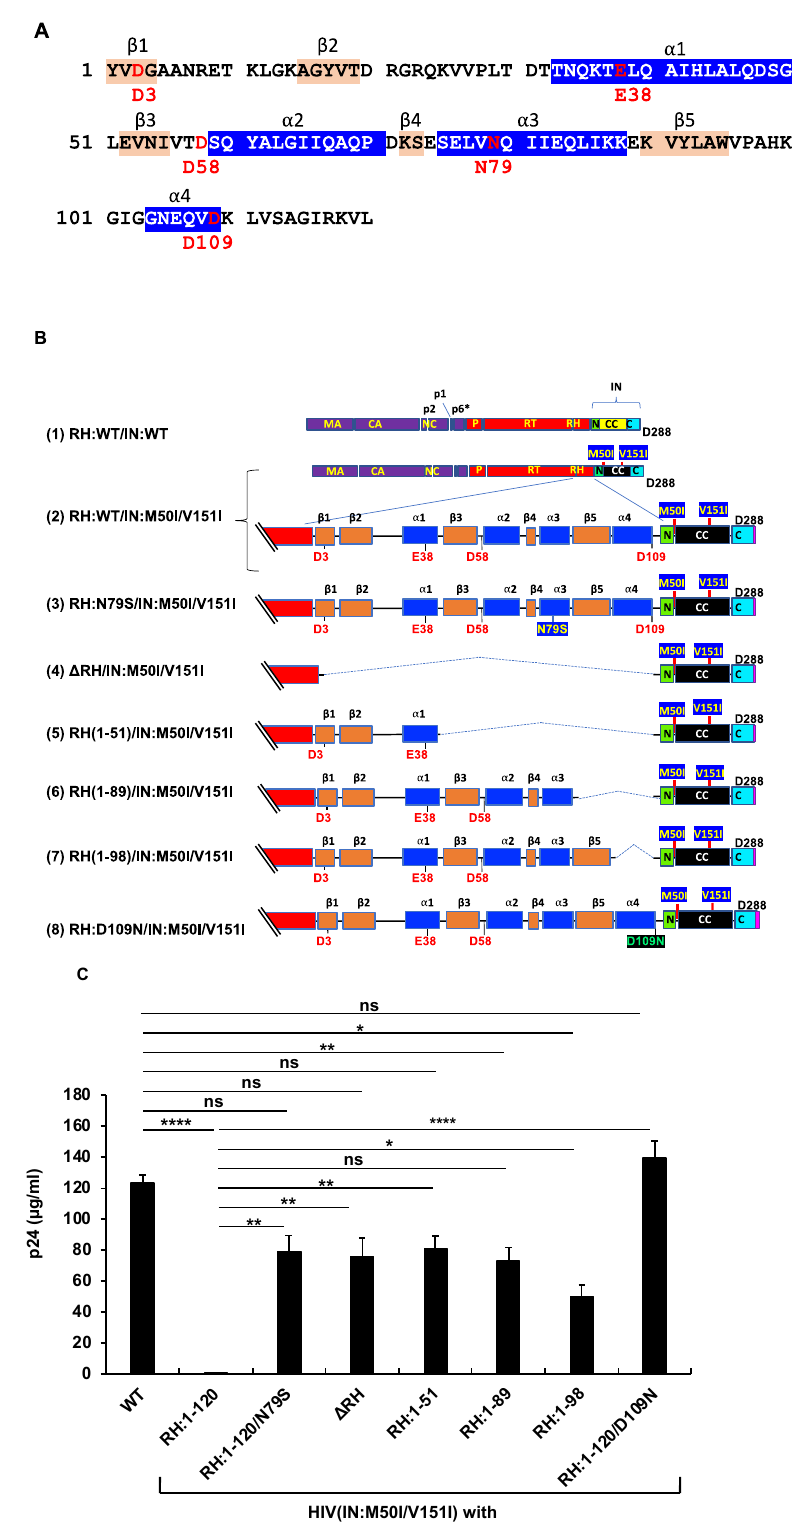
Figure 1. The C-terminal domain of RH regulates virus release and autoprocessing. ( A ) Amino acid sequence of RH. Amino acid sequence of RH of HIV NL4.3 [33] was obtained from GenBank (accession #: AF324493). The alpha helices are colored in blue, and the beta strands are colored in wheat; codons associated with the active sites (D3, E38, D58, and D109) and mutation position 79 (N79) are labeled and colored in red with numbering. ( B ) Diagrams of HIV mutants containing mutations in RH. The diagram indicates the structure of GagPol(WT) and variants. The numbers above the diagrams in- dicate codon positions in RH. Each mutant was created by inverting PCR or site-directed mutagen- esis, as described in the Materials and Methods (Section 2.3). MA: matrix protein; CA: capsid pro- tein; NC: nucleocapsid protein; P: protease; RT: reverse transcriptase; RH: RNase H; IN: integrase; N: the N terminal domain of IN; CC: the catalytic core domain of IN; C: the C terminal domain of IN; α 1~ α 4 and β 1~ β 5 are corresponding to domains of RH in Figure 1A. ( C ) Each construct was transfected into HEK293T cells. Transfection supernatants from HEK293T cells were collected, and then viral particles were pelted as described in the Materials and Methods (Section 2.4). Each viral pellet was resuspended in 1/100 of the transfection supernatants in complete culture media or PBS. p24 concentrations in the suspension were determined by measuring HIV p24 antigen by ELISA. Data indicate means ± SE (n = 5), and statistical analysis was conducted using one-way ANOVA (Prism). *: p < 0.05, **: p < 0.01, ****: p < 0.0001, ns.: not significant. Thus, RH:N79S may trigger a structural change in IN:M50I/V151I GagPol; subse- quently, it may induce the restoration of autoprocessing followed by maturation. Given this notice, we speculated that a particular domain(s)/region(s) of RH may be directly as- sociated with the recovery. We decided to determine how the RH domain(s) in the M50I/V151I mutant influenced autoprocessing and the virus maturation and constructed a series of HIV(M50I/V151I) variants containing different lengths of RH (Figure 1B). To evaluate the processing function of PR, we maintained the PR cleavage sequence at the junction between RH and IN in all variants; all mutants retained five amino acid (aa) up- stream sequences of the PR cleavage site from the C terminal of RH. Each plasmid con- struct was transfected into HEK293T cells. The released virus particles in the culture su- pernatants were collected by centrifugation and then resuspended in PBS or fresh culture medium, as described in the Materials and Methods (Section 2.4). The amounts of released virus particles were quantified using a p24 antigen capture assay. The processing of Gag and GagPol in the particles was analyzed by Western blot (WB) assays using anti-Gag or anti-PR